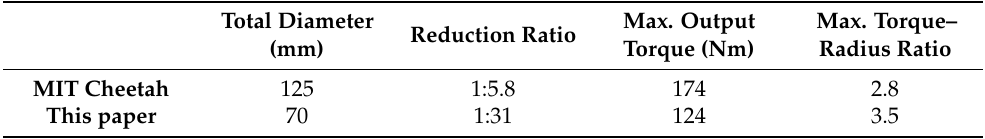
Table 1. Performance parameters comparison of actuator between MIT Cheetah and our